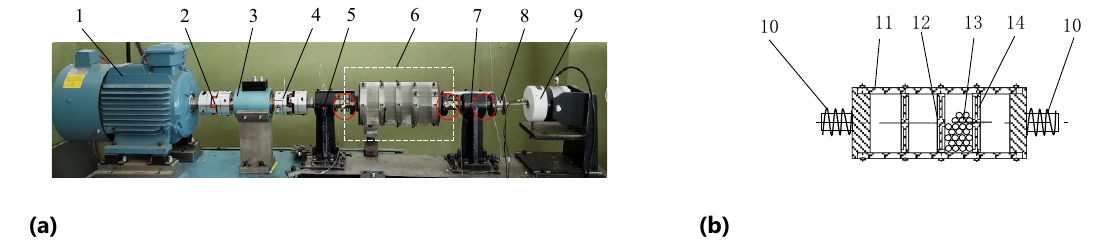
Figure 5. Test device of particle damping for vibration suppression: (a) Test device; (b) Particle damper. 1— frequency conversion motor; 2, 4—coupling; 3—tachometer; 5, 7—support linear bearing; 6—particle damper; 8—acceleration sensor; 9—vibration exciter; 10—spring; 11—barrel; 12—front wall; 13—particles; 14—rear wall.